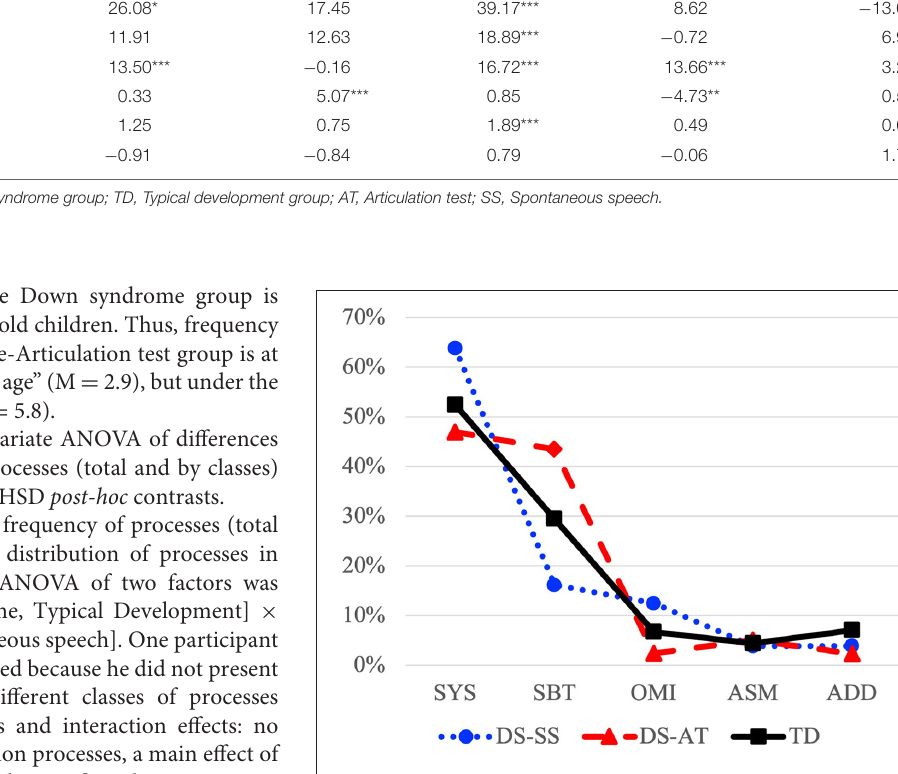
higher proportion of Syllable Structure and Omission processes than the TD group in line with absolute frequency (PPI)